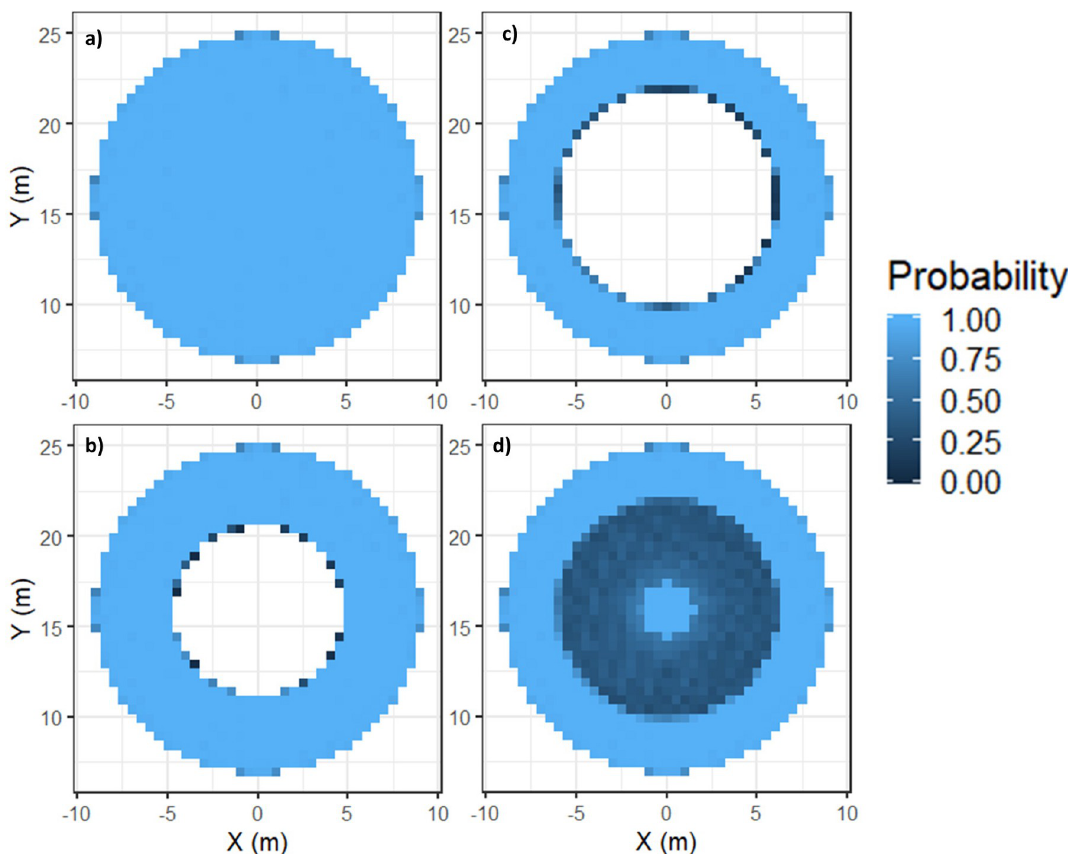
Fig 3. Probability of fatal collisions over the swept area of the device for scenario A1R1 for probabilities calculated with a) no collision speed threshold set (i.e., all collisions are fatal) b) above a collision speed threshold of 4.0 ms -1 and c) above a collision speed threshold of 5.1 ms -1 and d) all collisions with the head and collisions with the torso above a collision speed threshold of 5.1 ms -1